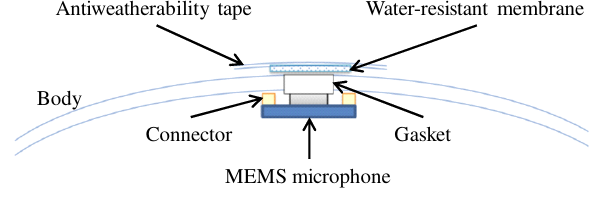
Figure 3. Internal structure of the